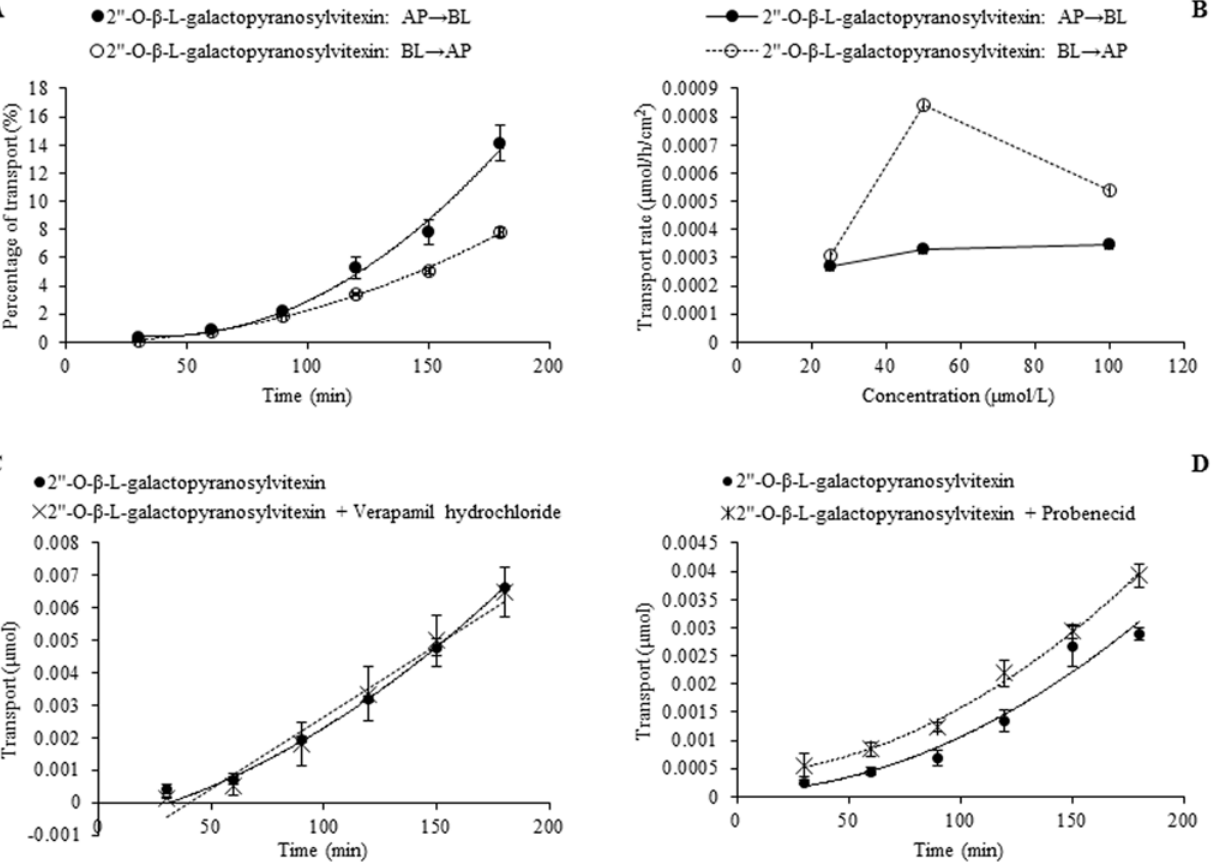
Fig 11. Transport of 2 ” - O - β -L-galactopyranosylvitexin across Caco-2 cell monolayer. Notes: (A) The percent transport of 2 ” - O - β -L- galactopyranosylvitexin as a function of time at 50 μ mol/L; (B) The transport rate of 2 ” - O - β -L-galactopyranosylvitexin as a function of concentration at 90 min; (C) The effect of verapamil hydrochloride on the transport of 2 ” - O - β -L-galactopyranosylvitexin as a function of time at 50 μ mol/L; (D) The effect of probenecid on the transport of 2 ” - O - β -L-galactopyranosylvitexin as a function of time at 50 μ